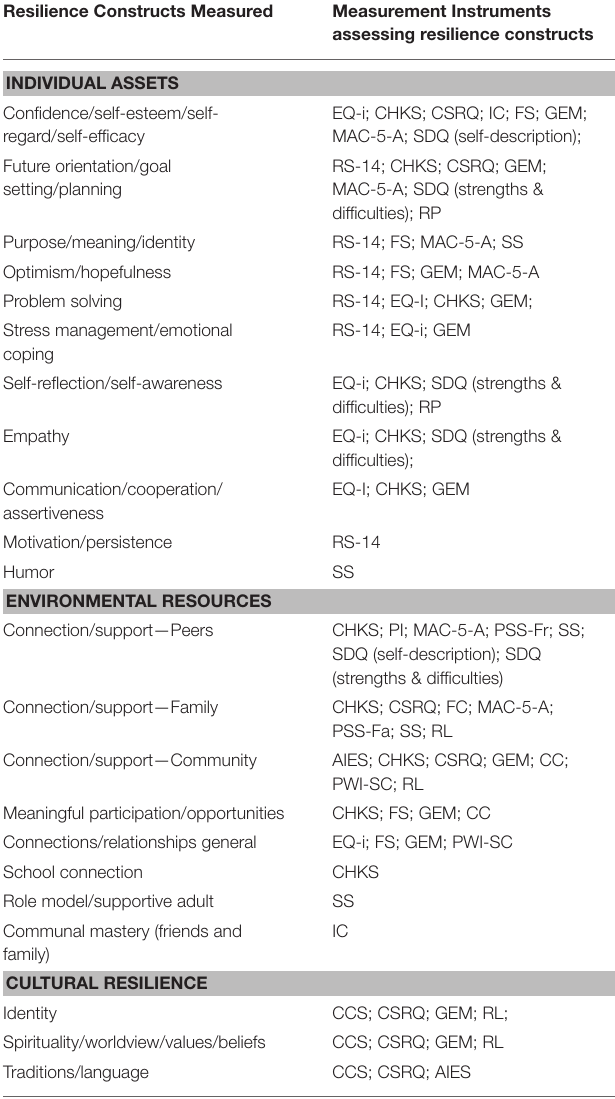
TABLE 3 | Resilience constructs measured. Resilience Constructs Measured Measurement Instruments assessing resilience